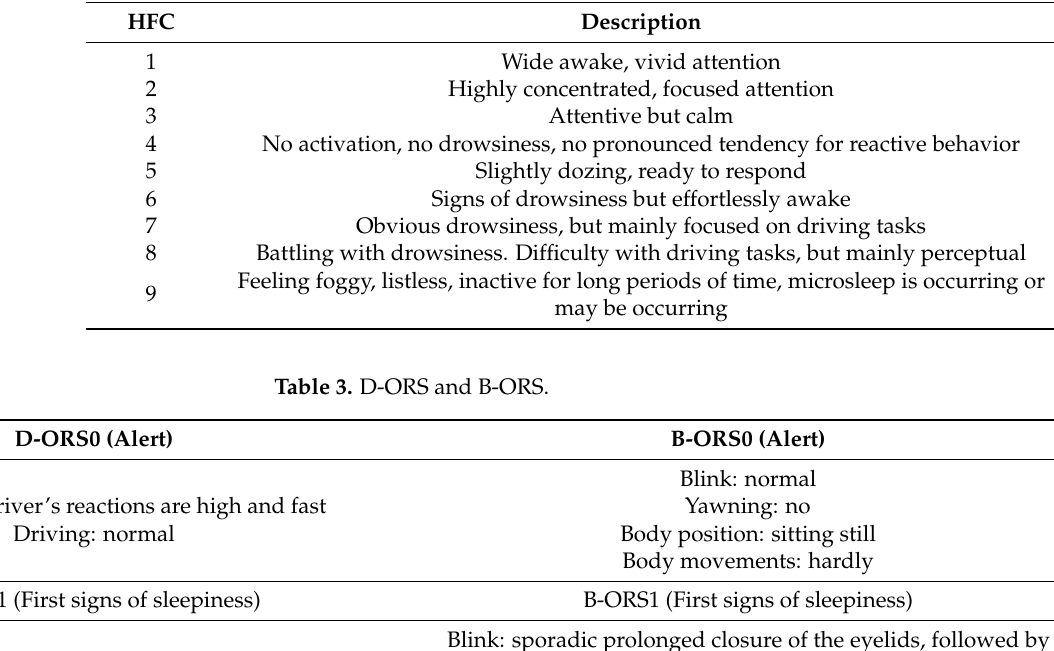
Table 2. HFC drowsiness scale.